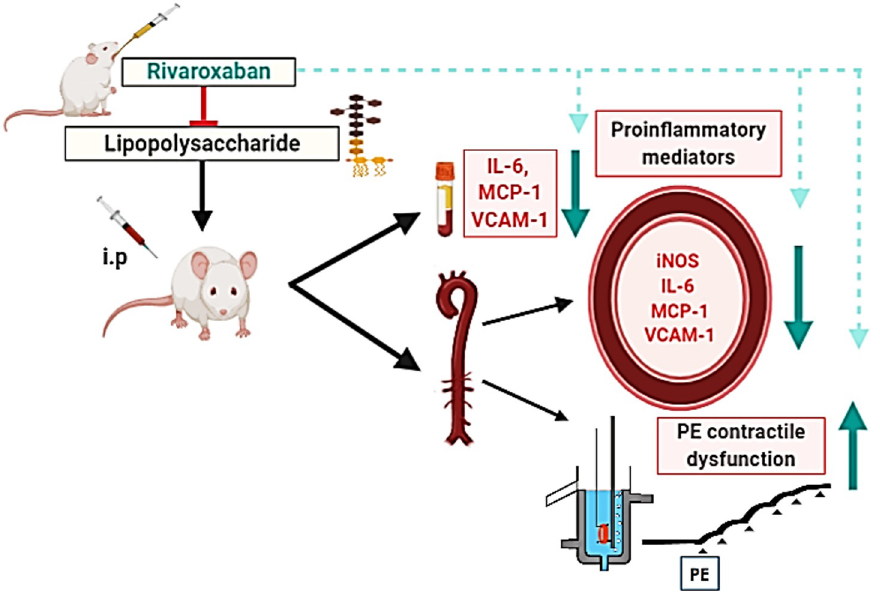
Fig 5. Schematic diagram for the protection of RVX against acute inflammation and vascular dysfunction following LPS-induced endotoxin shock. RVX pretreatment decreased the expression of pro-inflammatory mediators and adhesion molecules and improved aortic hypo responsiveness to PE induced by LPS in the aorta. The figure was prepared with BioRender (biorender.com).